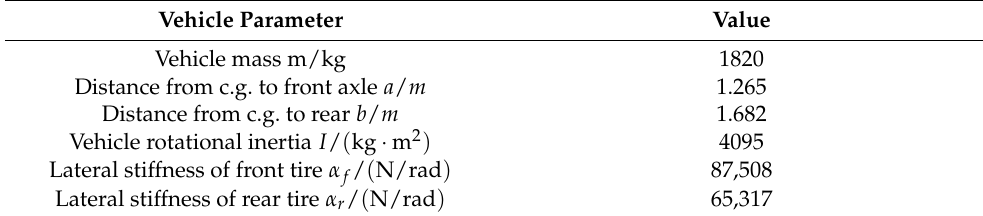
Table 3. Parameters for simulations.